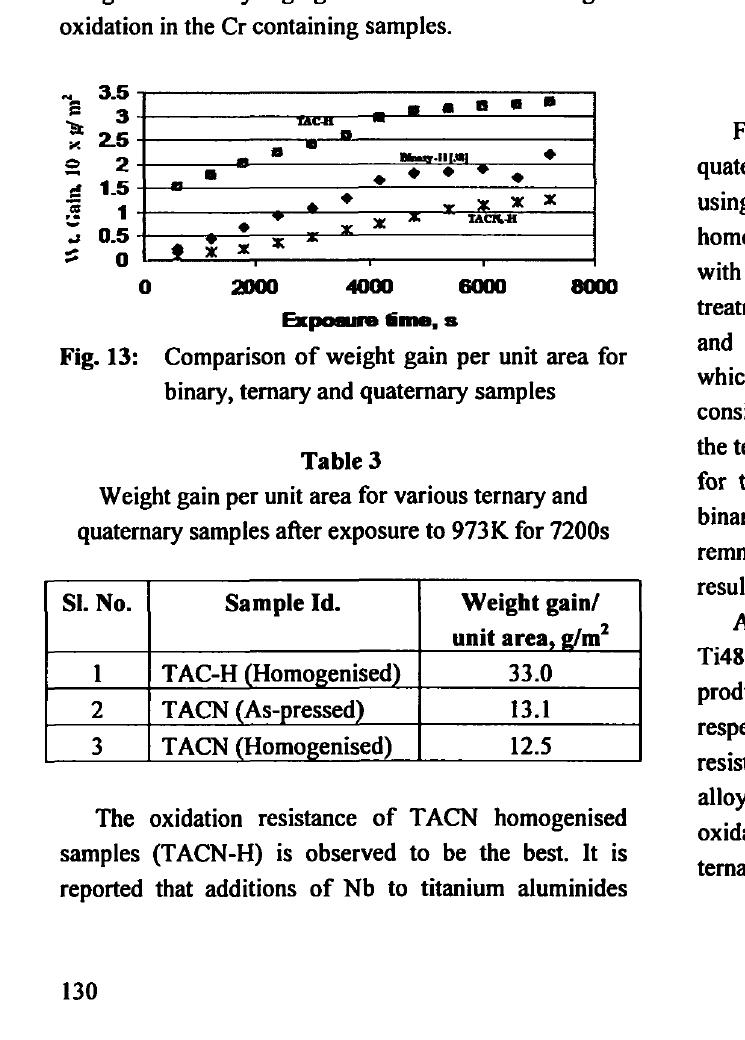
Fig. 13: Comparison of weight gain per unit area for binary, ternary and quaternary samples